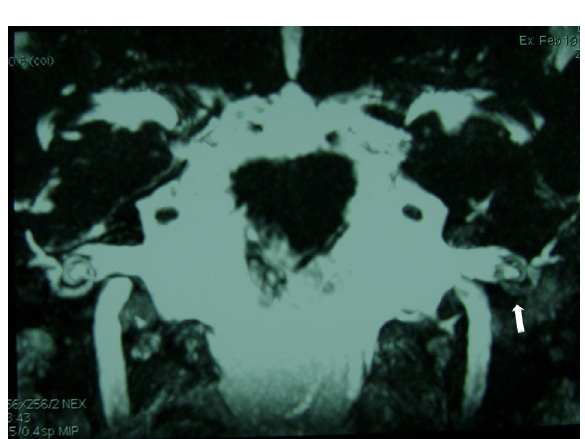
Left temporal bone CT, axial view, showing cochlear ossification. Note : underdeveloped mastoid filled with soft tissue-density